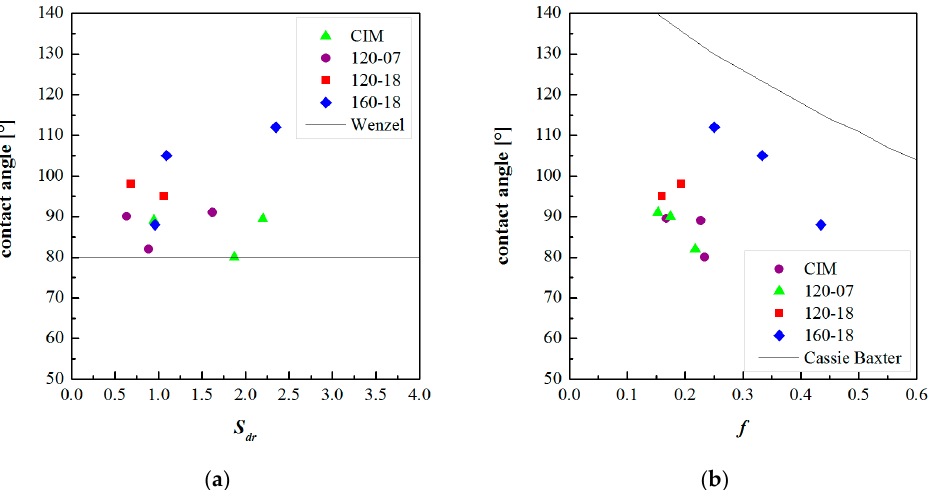
Figure 9. Contact angles vs. the parameters S dr ( a ) and f ( b ) calculated from the AFM flattened maps. The Wenzel and the Cassie–Baxter models were also reported in each plot.